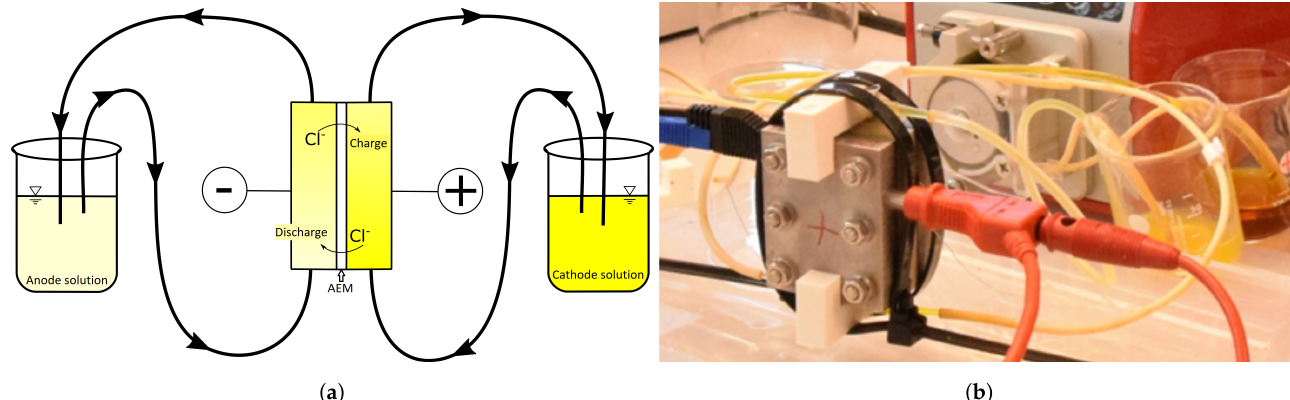
Figure 2. Illustration of the flow cell setup. ( a ) Setup schematic ( b ) Photograph with peristaltic pump and solutions in the